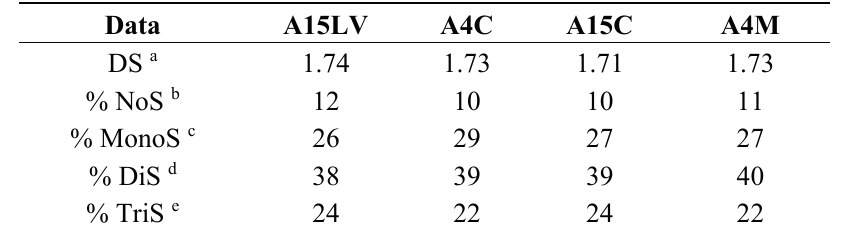
Table 3. Degree of substitution (DS) and monomeric composition of commercial methylcelluloses expressed in number percents